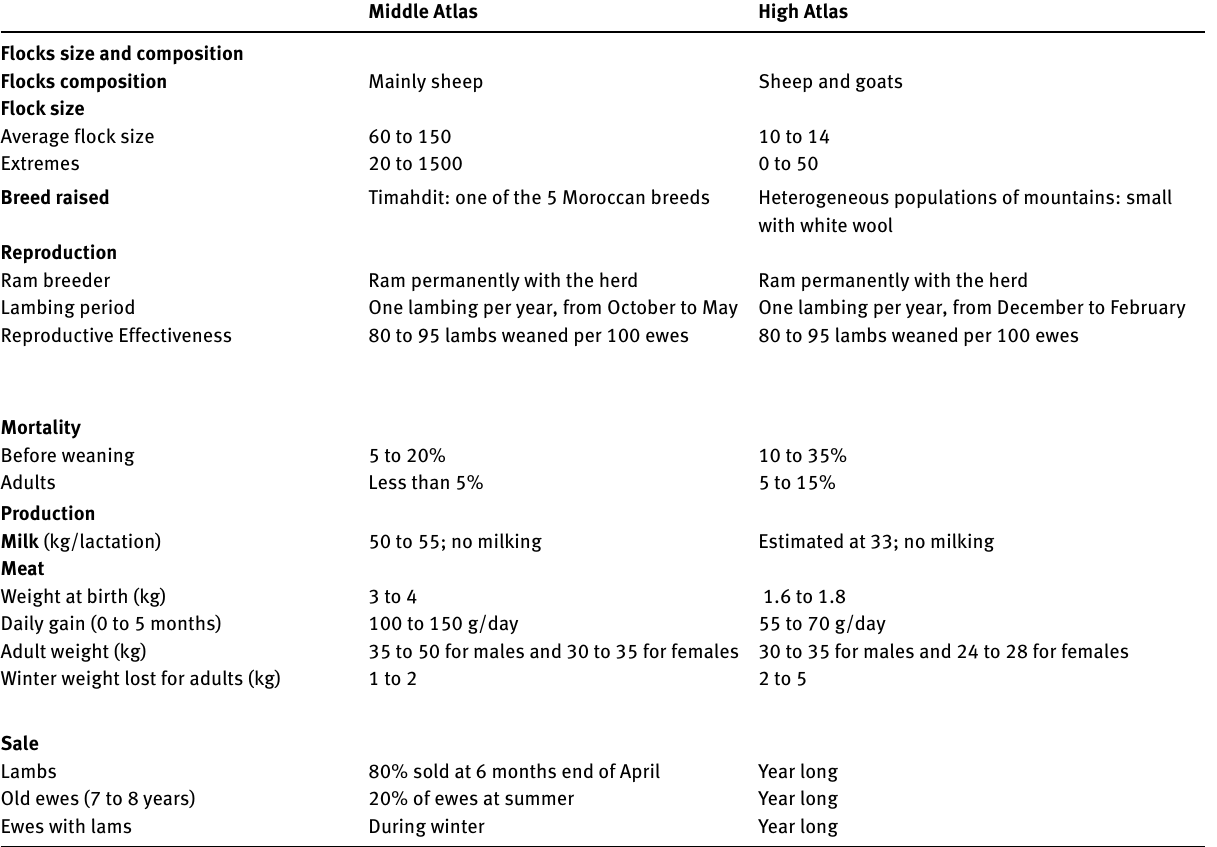
Table 1: Main characteristics of small ruminant flocks in Mountainous